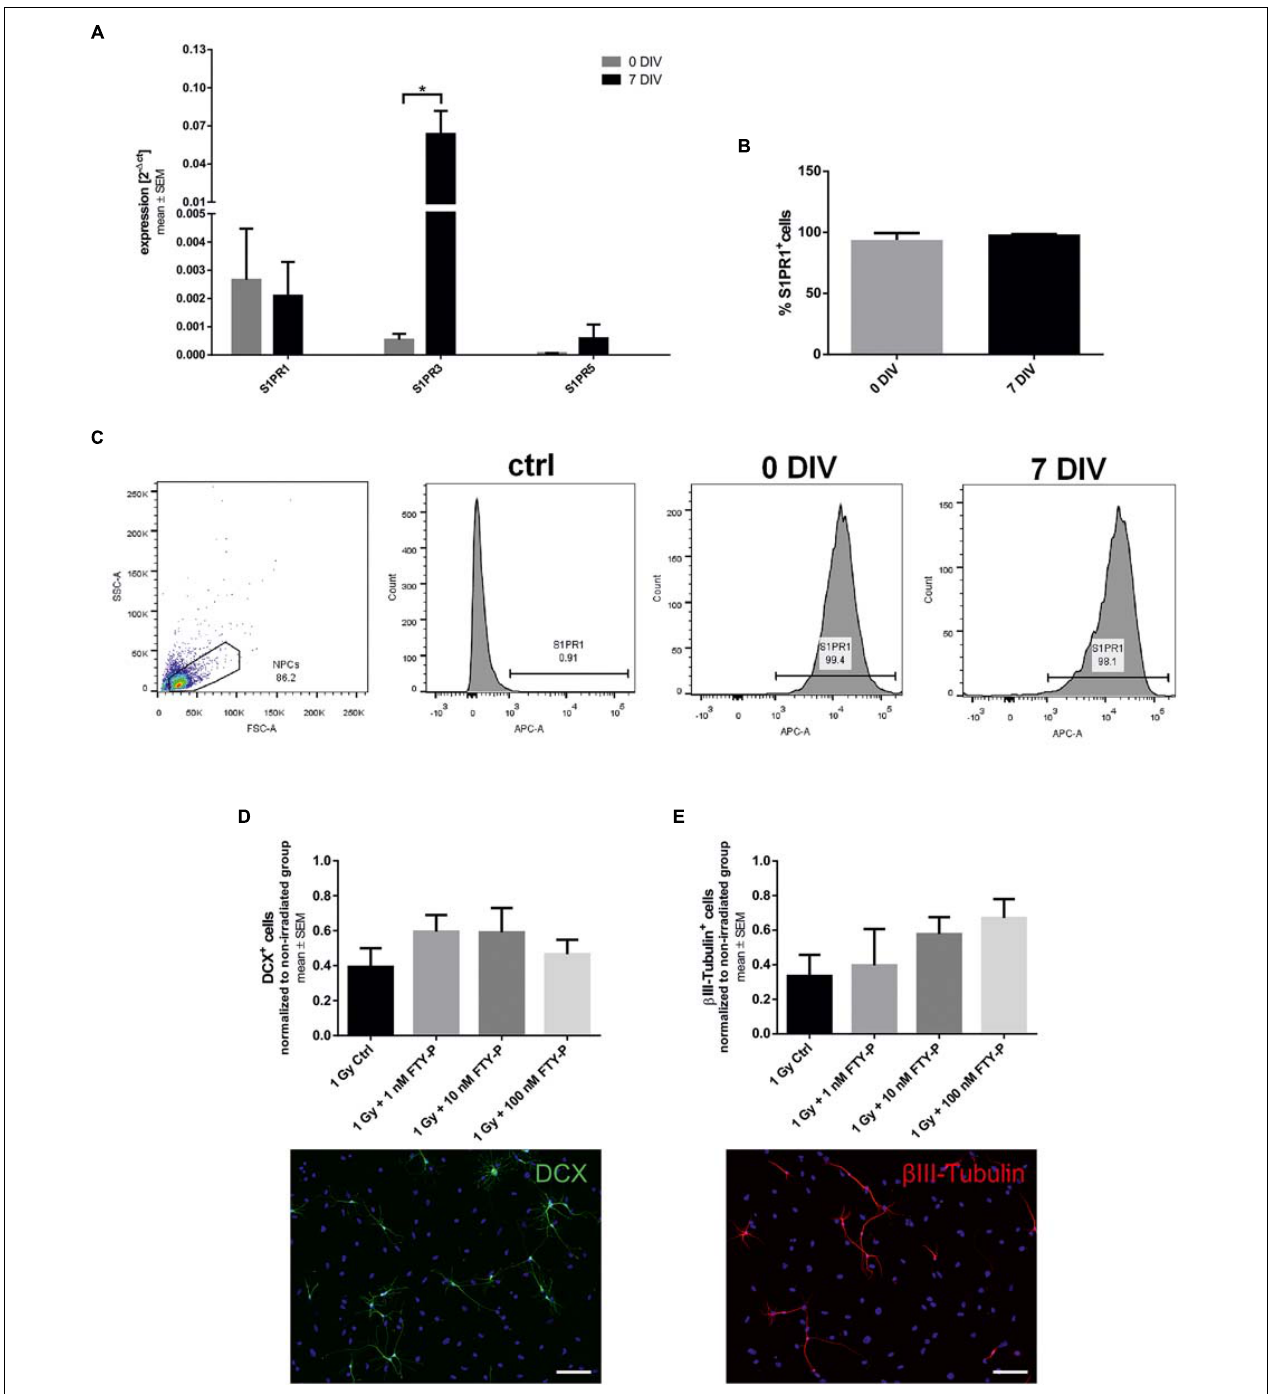
FIGURE 1 | Sphingosine-1-phosphate receptor expression and differentiation of FTY720P-treated neuronal stem cells. (A) Embryonic neural precursor cells (NPCs) were explanted from E13 C57BL/6 wildtype mice and cultured as neurospheres. The mean expression level of the sphingosine-1-phosphate receptors S1PR1, S1PR3, and S1PR5 on undifferentiated NPCs (0 days in vitro , DIV) and on NPCs after 7 days of differentiation (7 DIV) was analyzed by qt-PCR and normalized to GAPDH and β -actin (mean ± SEM, S1PR1, S1PR5: n = 3, S1PR3 n = 4). (B) Cells were stained against S1PR1 and analyzed via fluorescence-activated cell sorting (FACS). (C) Representative pictures of the FACS gating strategy and of the unstained control. (D,E) NPCs were treated with different concentrations of FTY720P beginning on day 0 of differentiation and received an irradiation of 1 Gy after 6 days. Differentiation was analyzed 24 h after irradiation by immunocytochemistry with doublecortin (DCX, B ; 24 h: n = 4) and β III-tubulin ( C ; 24 h: n = 3). Irradiated groups were normalized to their sham irradiated counterparts. Results are presented as mean ± SEM. N represents the number of independent experiments. Statistical analysis with Mann–Whitney test (A) or Kruskal–Wallis (B,D,E) . ∗ p < 0 . 05. Representative examples of each staining are shown at the bottom, scale = 100 µ